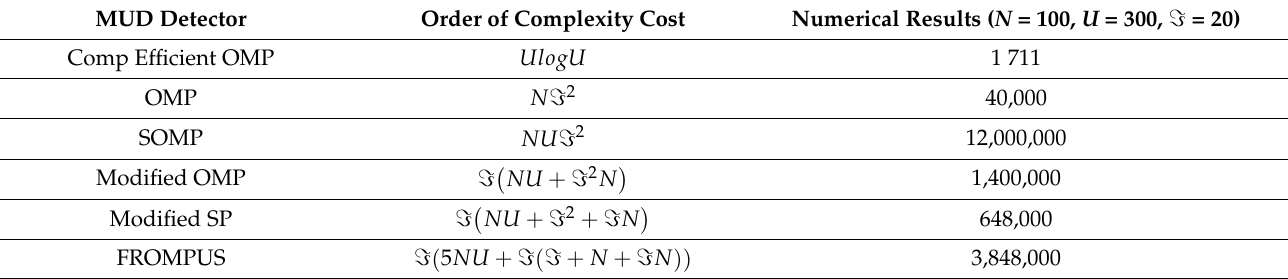
Table 1. Comparative computational complexity